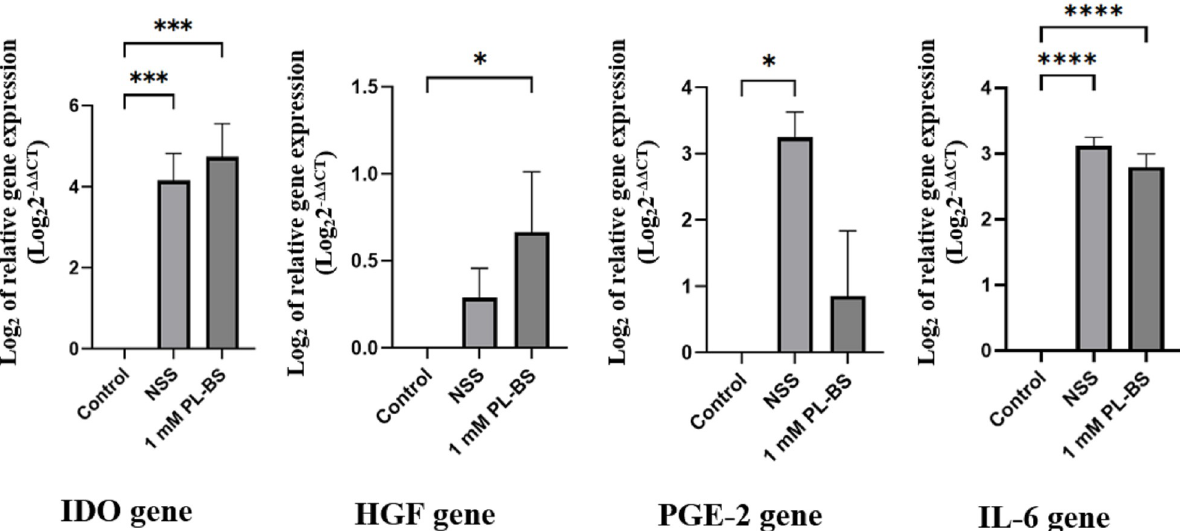
Fig 5. Effect of a hypothermic solution on the expression of immunomodulatory genes. Based on real-time RT-PCR, the level of IDO and IL-6 expression significantly increased when cAD-MSCs were stored in NSS or 1 mM PL-BS (p < 0.001). The expression level of HGF significantly increased in cAD-MSCs stored in 1 mM PL-BS compared to non-stored cells (p < 0.05). The PGE-2 expression level in NSS stored-cAD-MSCs was significantly higher than that in non-stored cells (p < 0.05). Remark symbols; IDO = indoleamine 2, 3-dioxygenase, IL-6 = interleukin-6, HGF = hepatocyte growth factor, and PGE-2 = prostaglandin E2; Lowercase letters above the bars indicate a significant difference compared to the control group; a = p < 0.05, c = p < 0.001, and d = p < 0.0001.